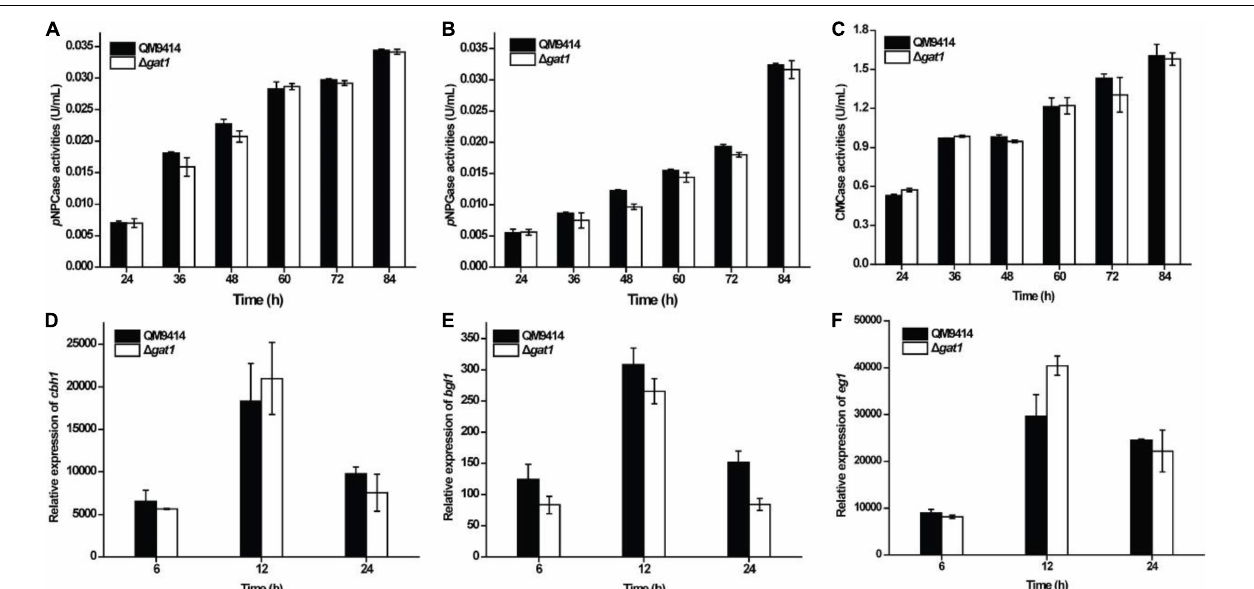
FIGURE 3 | Deletion of gat1 hardly affected cellulase production on Avicel cellulose. (A–C) Extracellular cellobiohydrolase (A) , ß-glucosidase (B) , and endoglucanase (C) activities of the culture supernatant from QM9414 and (cid:49) gat1 . (D–F) Transcriptional analyses of cellulase encoding genes including cbh1 (D) , bgl1 (E) and eg1 (F) using quantitative RT-PCR. Strains were cultivated on 1% (w/v) Avicel cellulose for the indicated time periods. Values in this figure are the mean of three biological replicates. Error bars are the SD from these replicates. No significant differences were observed in cellulase activities or gene transcription between (cid:49) gat1 and